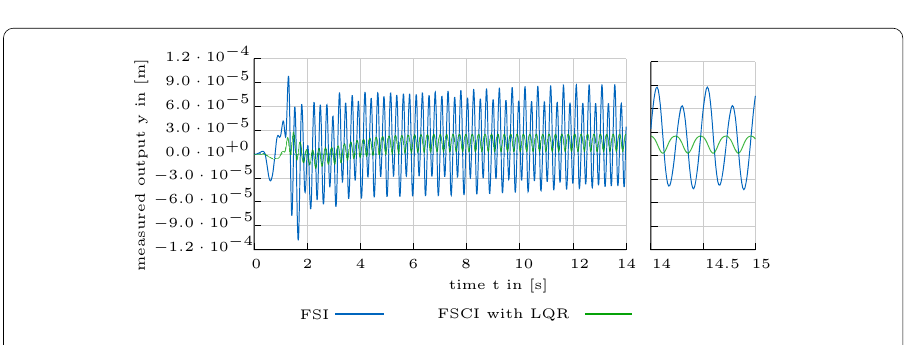
Fig. 12 Results: FSI and FSCI with LQR ( γ = 10 4 )